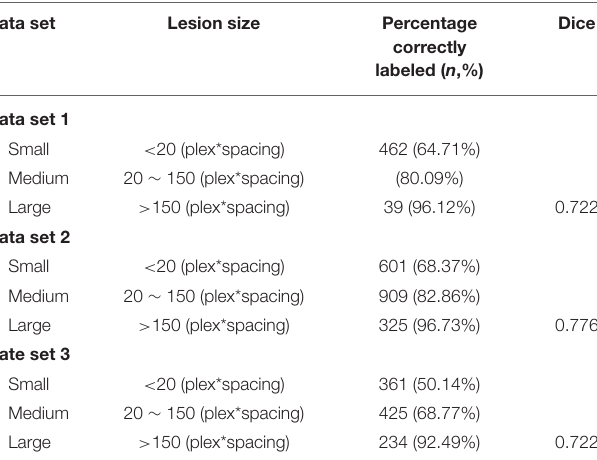
TABLE 2 | Validation Test 1.